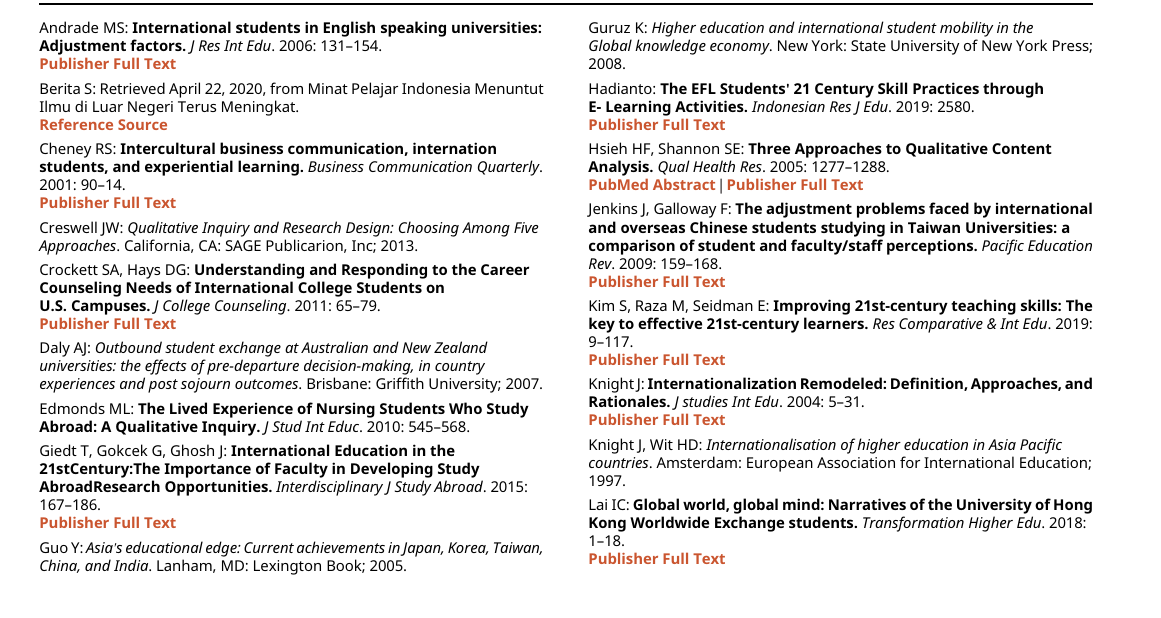
Figshare: Raw Data Wolter, https://doi.org/10.6084/m9.figshare.14131646.v2 (Silalahi, 2021). Data are available under the terms of the Creative Commons Zero “ No rights reserved ” data waiver (CC0 1.0 Public domain